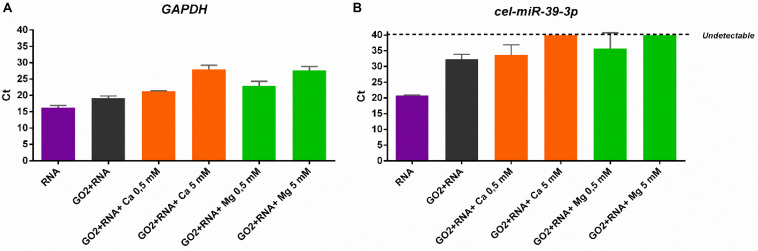
(A) qPCR analysis of GAPDH and (B) cel-miR-39-3p levels in supernatants after incubation with GO and different cations.